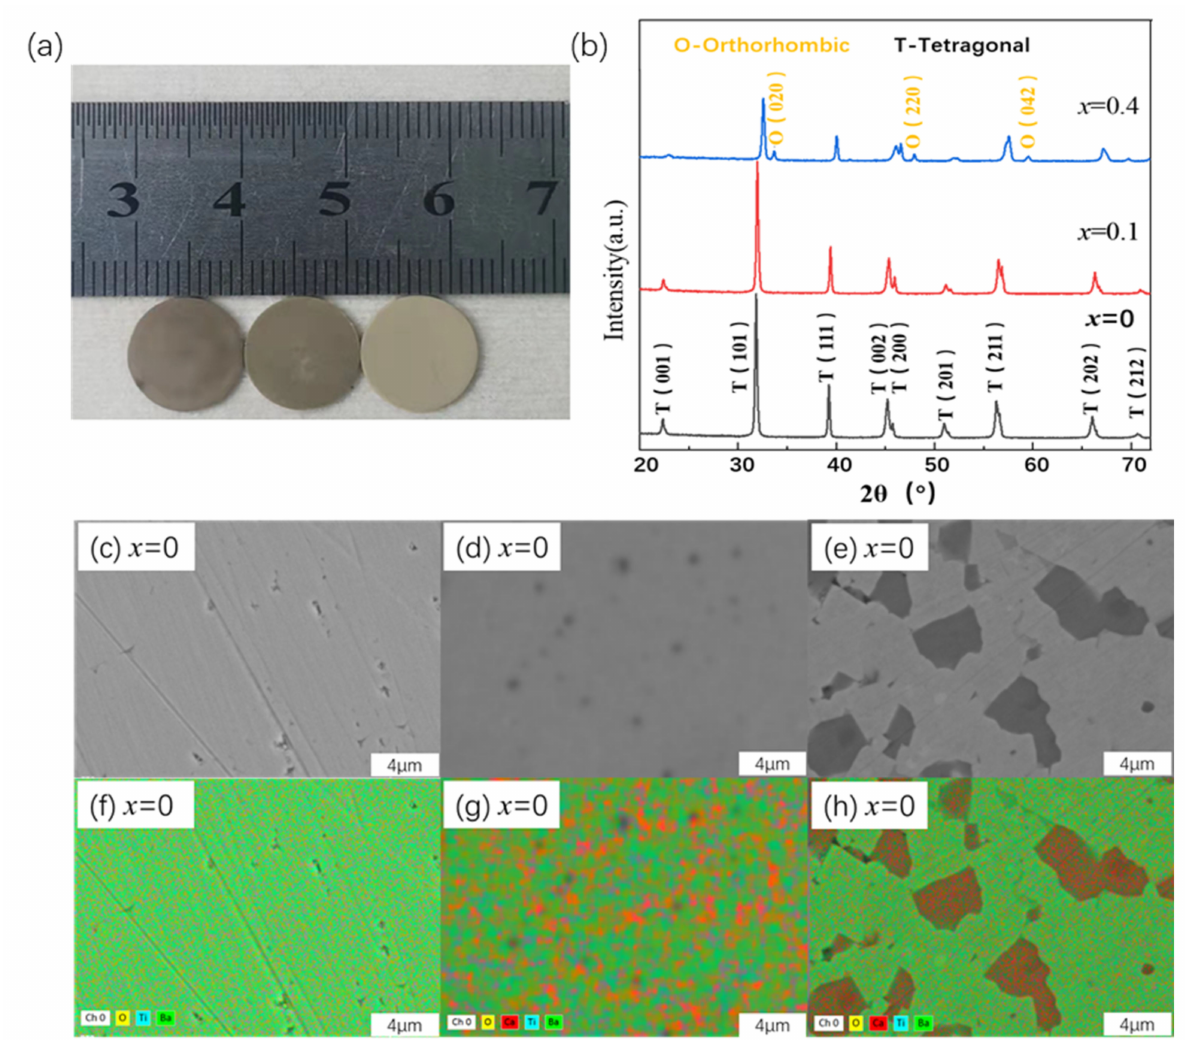
Figure 2. ( a ) Ba 1 − x Ca x TiO 3 ( x = 0, 0.1, 0.4) ceramic samples and ( b ) their XRD patterns. ( c – e ) SEM im- ages of the three ceramic samples. ( f – h ) EDS elemental mapping images of the three ceramic